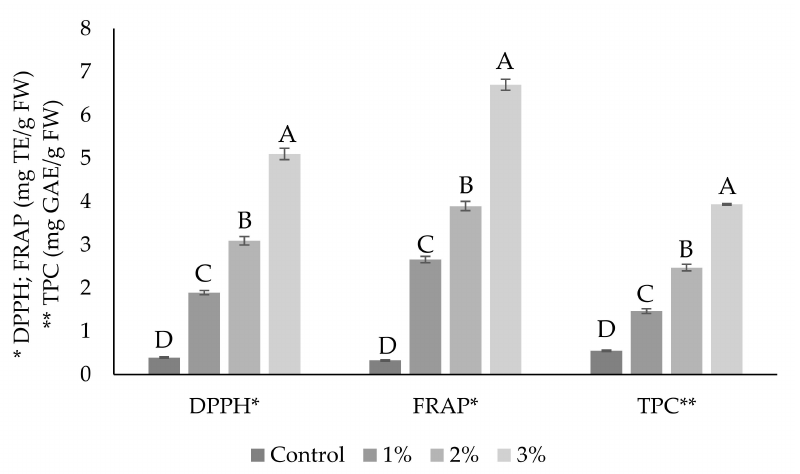
Figure 2. Antioxidant activity (DPPH and FRAP) and total polyphenol content (TPC) of fish sausages without (control) and with 1%, 2%, and 3% ( w / w ) of onion peel powder. Bars represent means ( n = 8 for DPPH and FRAP; n = 4 for TPC) ± standard deviation. A–D Bars within the same analysis with di ff erent letters di ff er significantly ( p <